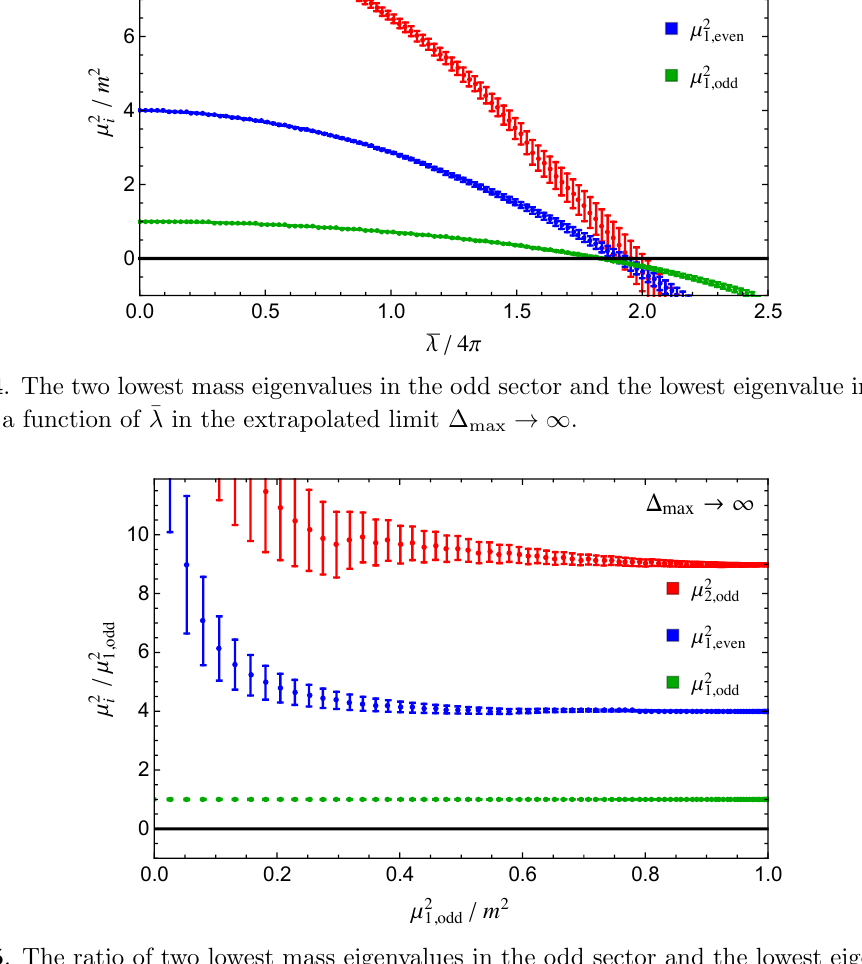
in the extrapolated limit (cid:1) max ! 1 1 ; odd